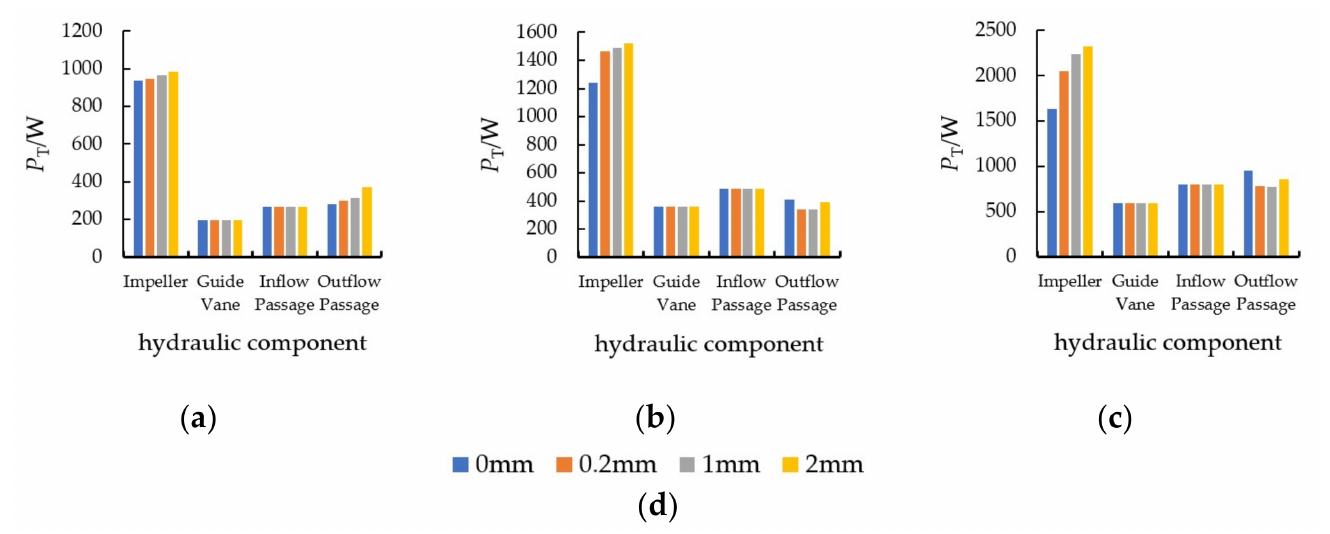
Figure 10. Influence of tip clearance on total dissipation under turbine condition; ( a ) 0.8 Q des ; ( b ) 1.0 Q des ; ( c ) 1.2 Q des ; ( d )